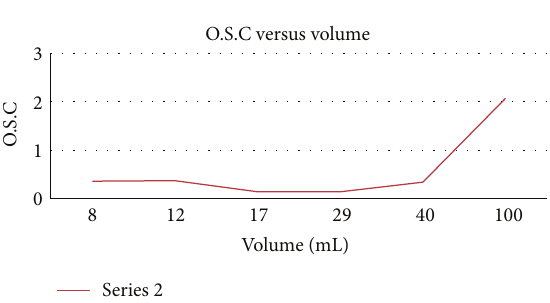
Figure 3: XRD patterns of EPFB fibre.